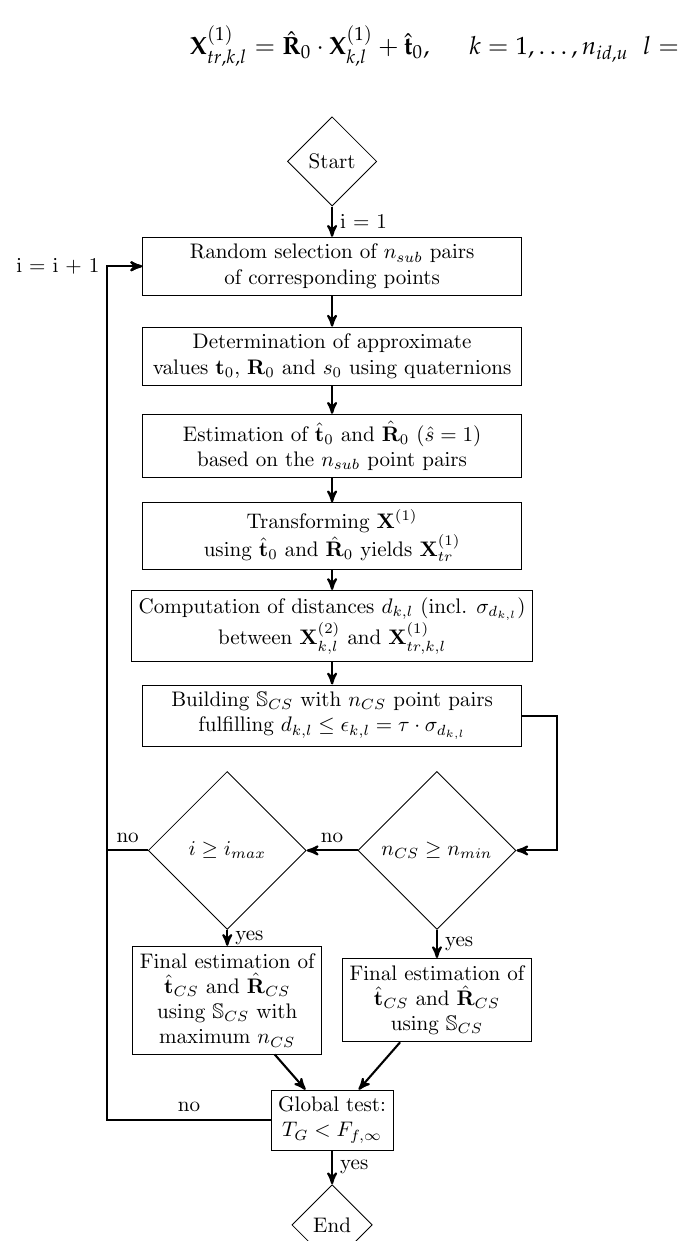
Figure 4. Flow chart of the RANSAC-based estimation of rigid body movements [30]. The Euclidean distance